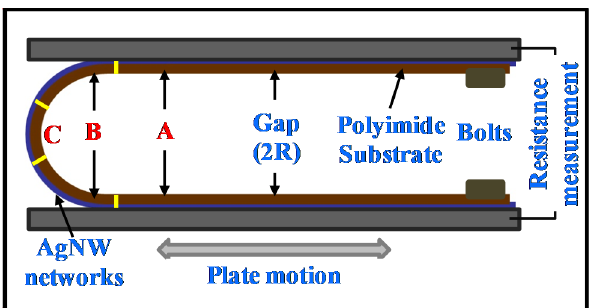
Figure 1. Schematic illustration of a cyclic bending tester. Reproduced with permission from ref. [28]. Copyright 2014, Wiley.